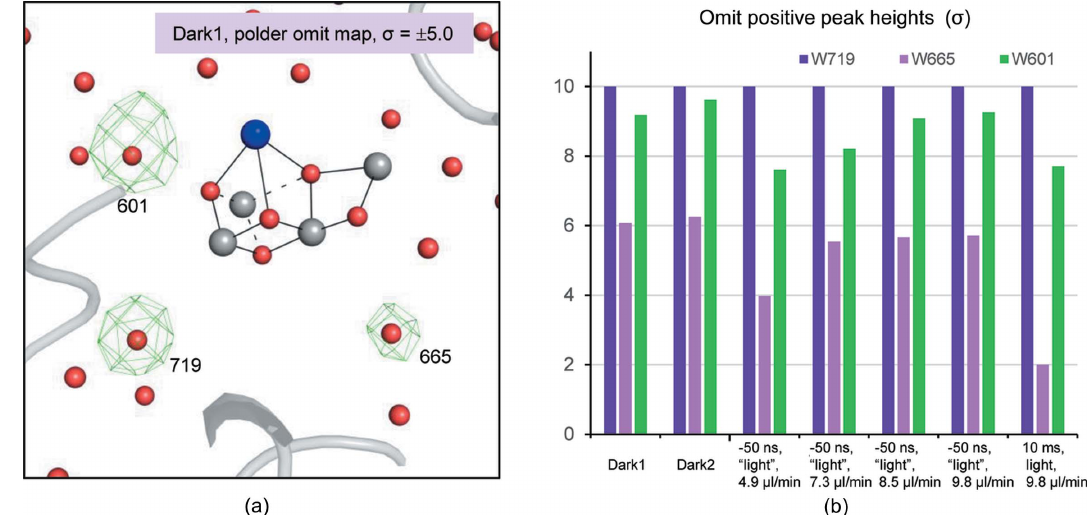
Figure 4 ( a ) S 1 -state structure superposed with the omit map for W601, W665 and W719 calculated from the dark1 dataset contoured at +5.0 (cid:6) (green) and (cid:3) 5.0 (cid:6) (orange). ( b ) Positive peak heights of the omit map determined for the water molecules. W719 is a well defined water molecule that does not change its structure during the S-state cycle, thus its positive omit density was used as a baseline. The figure shows relative heights of omit maps of water molecules based on that of